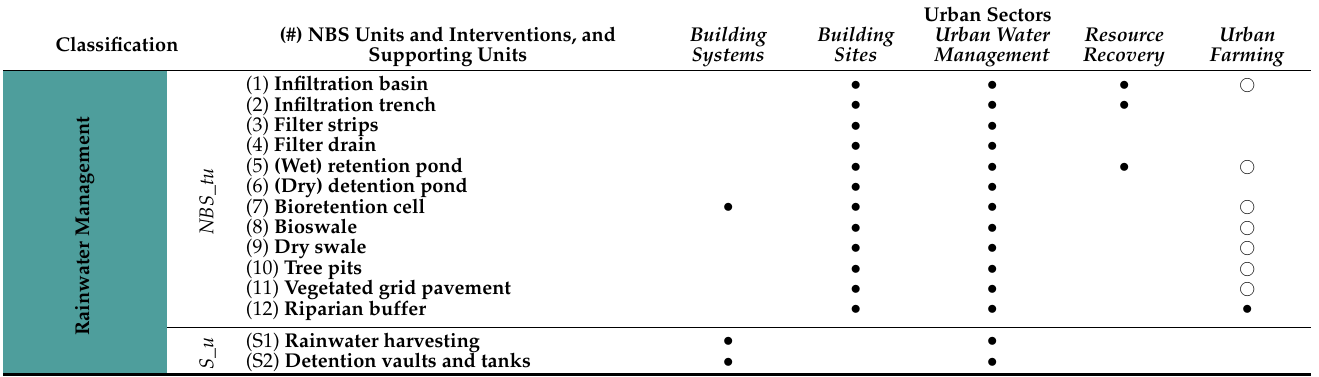
Table 1. Relevance of NBS units and interventions (NBS_u/i) and supporting units (S_u) for different sectors, i.e., working groups of the COST Action Circular City ( • = relevant; = might be relevant, depending on system design). NBS_tu = (cid:35) technological units; NBS_su = spatial units; NBS_is = soil interventions; NBS_ir = river interventions; S_u = supporting